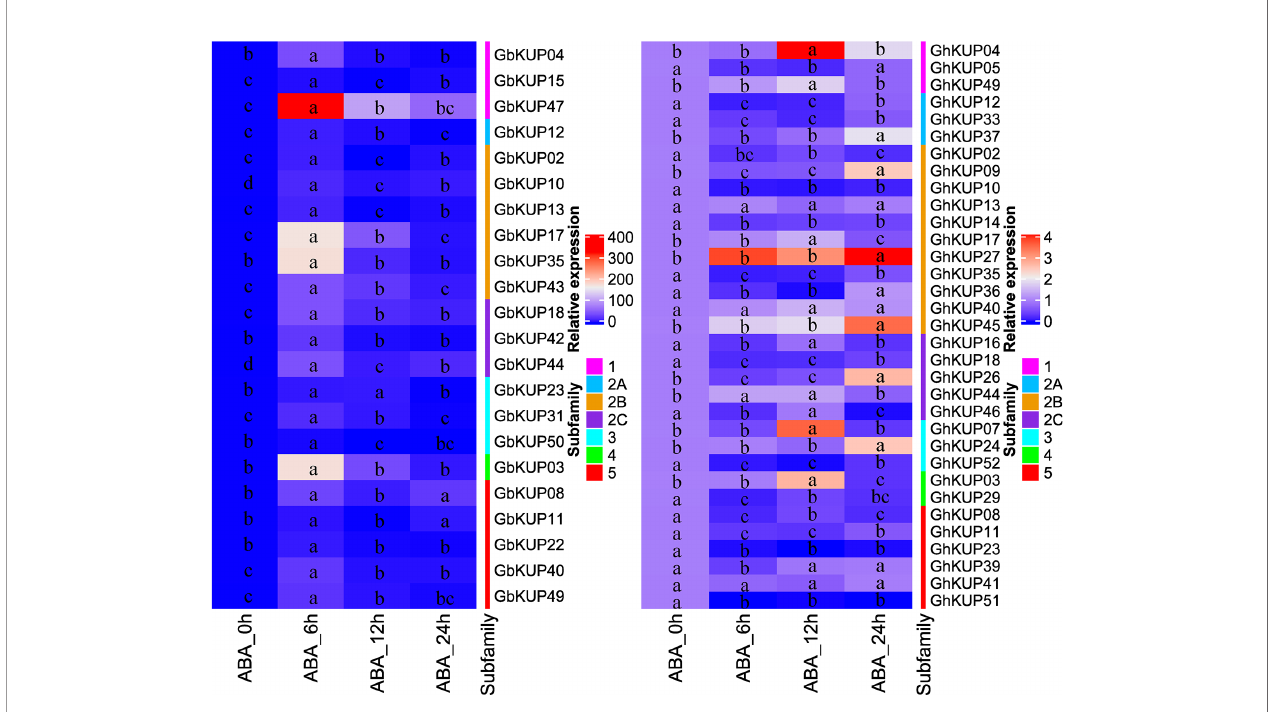
FIGURE 8 | Heat map representation of GhKUP and GbKUP expression levels under ABA stress. Two color bars represent relative expression values and KUP subfamilies. Expression levels with the same letter in each cell do not signi fi cantly differ at P < 0.05 as revealed by Duncan ’ s multiple